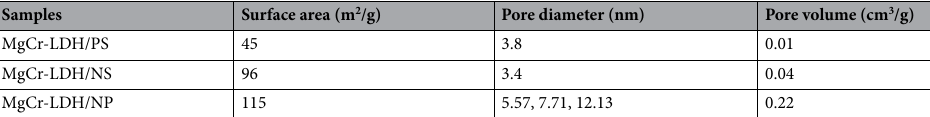
Table 1. BET Surface area, pore diameter and pore volume of the MgCr-LDH/PS, MgCr-LDH/NS and MgCr- LDH/NP